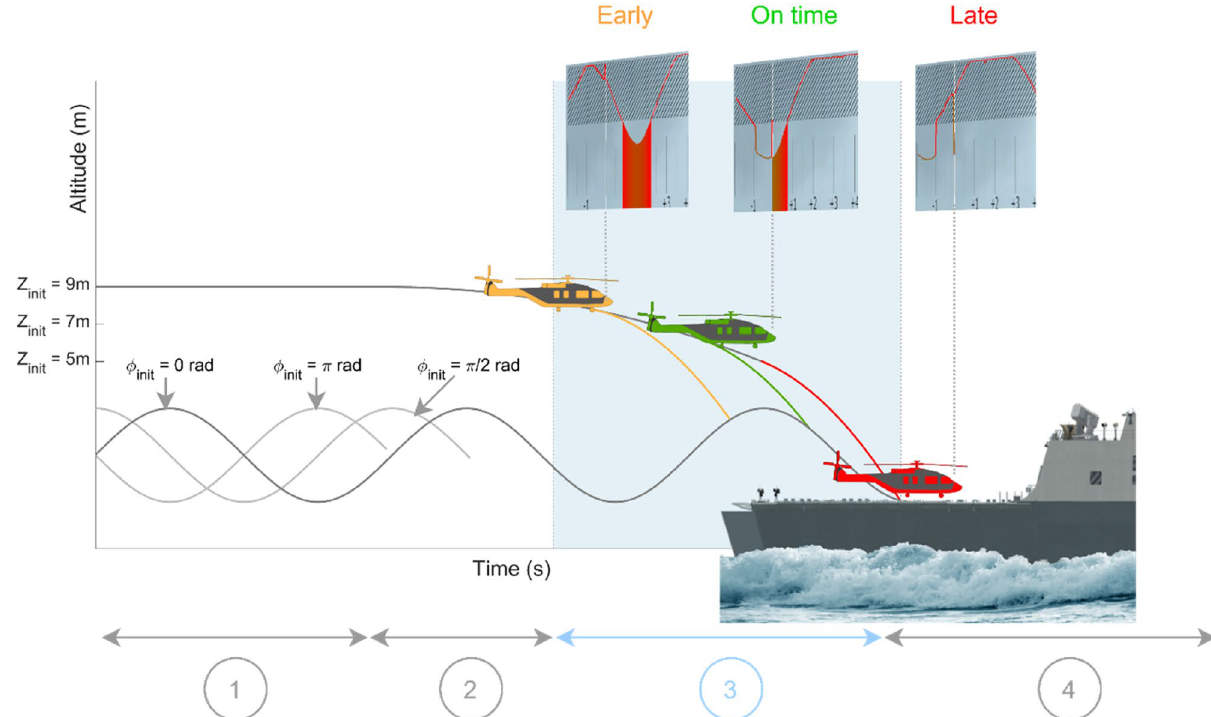
Figure 4. Unfolding of trials. (1) the helicopter hovered in a stationary position in Earth reference at an initial altitude Z init . The countdown indicated the remaining time in this stationary position. (2) The helicopter slowly decreased altitude (lift is reduced to 97,119 N). A second countdown was then presented, showing, how much time was left before participants were allowed to press either the "yes" or "no" button. (3) The second countdown disappeared when it reached 0 s. and participants were then allowed to either attempt the deck-landing maneuver by pressing "yes", or abort it by pressing "no". (4) If no response occurred, the helicopter reached the deck and participants were given some feedback information to encourage them to respond in the subsequent trials. Grey arrows show the phases during which participants could not press the "yes" or "no" buttons (they were instructed not to respond during these phases, and any responses occurring during these phases were not taken into account). The light blue arrow shows the time interval during which participants were expected to produce a